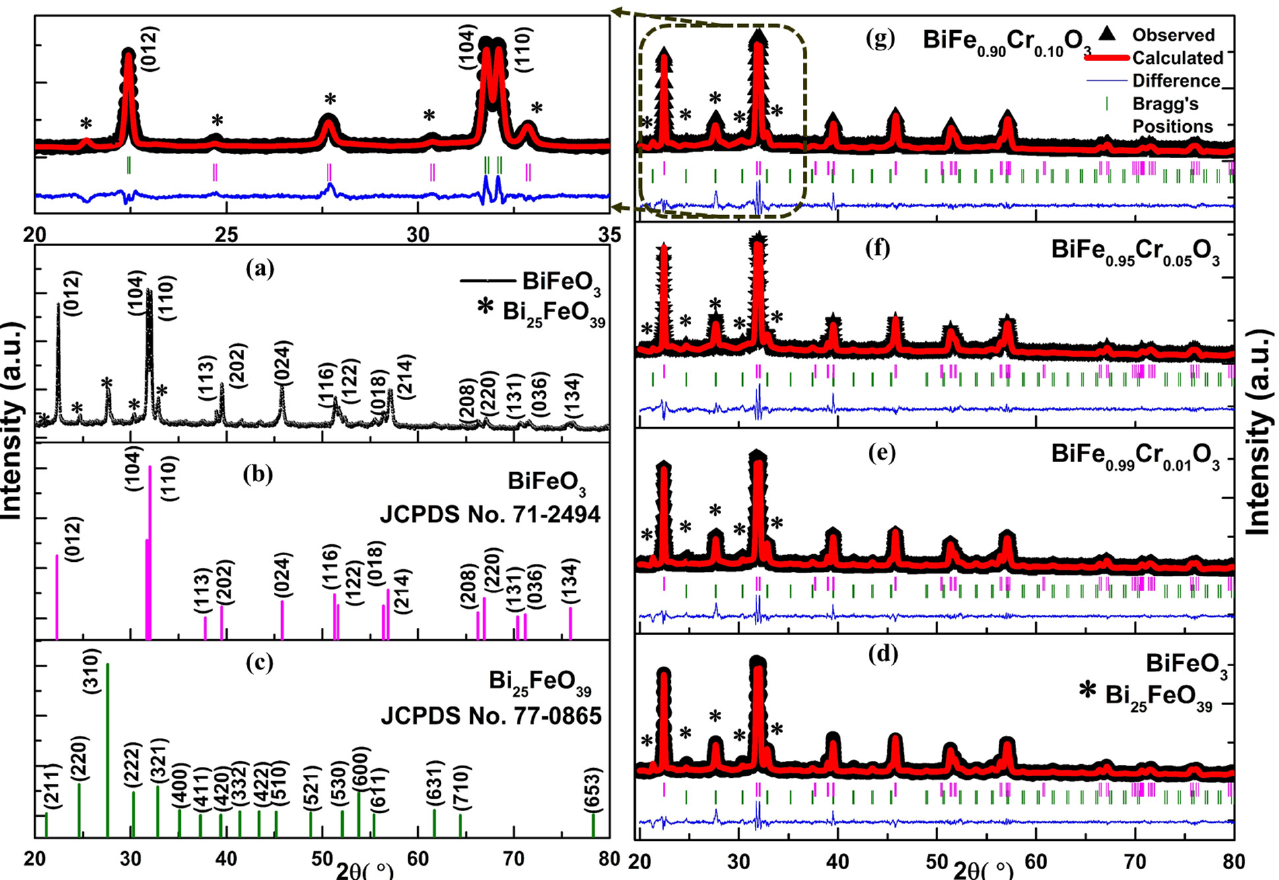
Figure 1. ( a ) XRD patterns of the undoped BiFeO 3 showing the peak positions and * represent the secondary phase of Bi 25 FeO 39 . ( b , c ) JCPDS card numbers indicating peaks for BiFeO 3 and Bi 25 FeO 39 , respectively. ( d – g ) The Rietveld refinement of the theoretically calculated patterns (red) superimposing the experimental data (black) for BiFe 1 − x Cr x O 3 (0 ≤ x ≤ 10) nanoparticles. The difference between the two is indicated by the blue line at the bottom; the Bragg positions for BiFeO3 phase are indicated by the pink vertical lines; the Bragg positions for the secondary phase (Bi 25 FeO 39 ) are indicated by the vertical green lines. Table 1. Density of the compound and phase fraction obtained after Rietveld refinement.